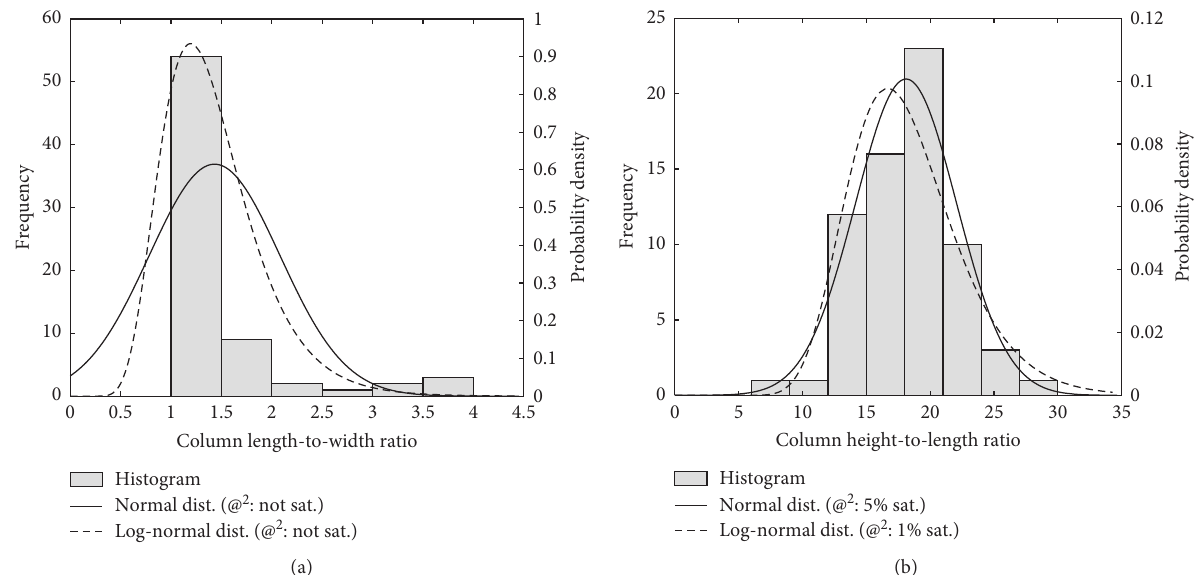
Figure 19: Histogram and probability distributions associated with the columns: (a) length-to-width ratio and (b)